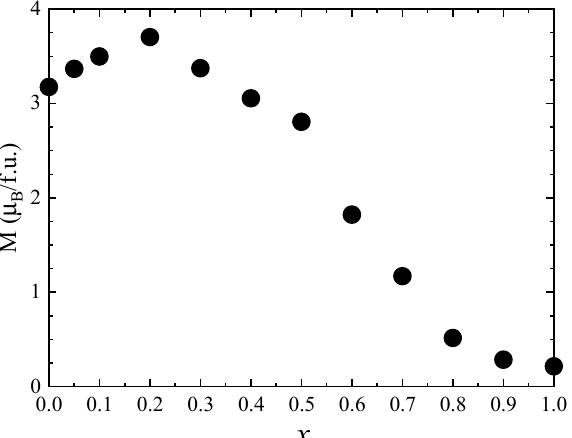
Figure 9. Hysteresis loops recorded at room temperature for Co 1- x Zn x Fe 2 O 4 nanoparticles .